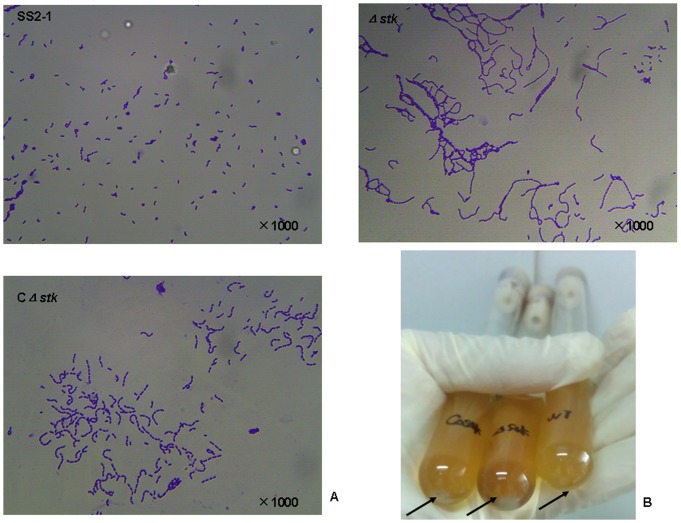
Cell morphology of SS2-1,Δstk and CΔstk.(A)Light microscope morphology of SS2 strains using Gram staining. (B)Sedimentation of bacteria cultured in THY for 12 h with gentle shaking. The arrows indicate the sedimented cells at the bottom of tubes.